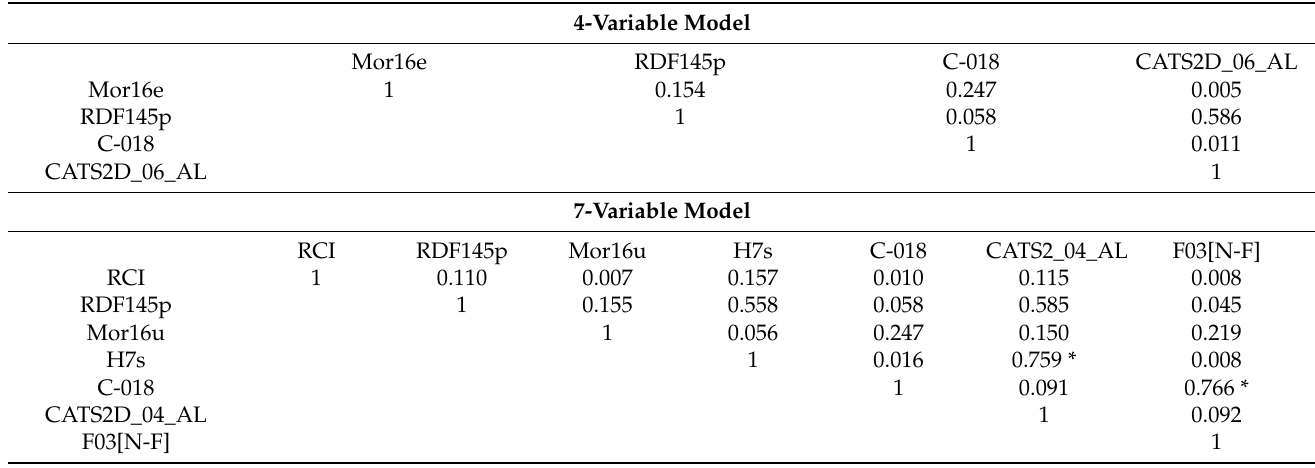
Table 4. Correlation matrix of included descriptors in best four- and seven-variable QSAR models predicting TEAC for the entire set of compounds (72).